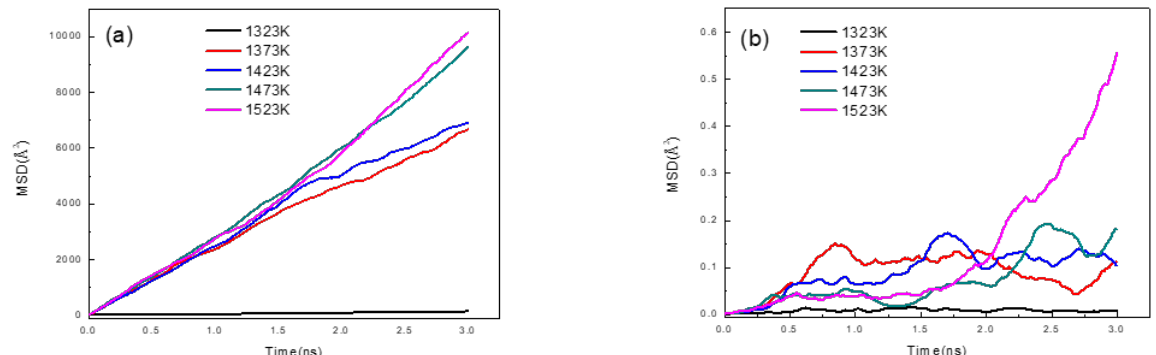
Figure 4. Mean square displacement (MSD) curves of: ( a ) Cu atoms at different temperatures; ( b ) Fe atoms at different temperatures.